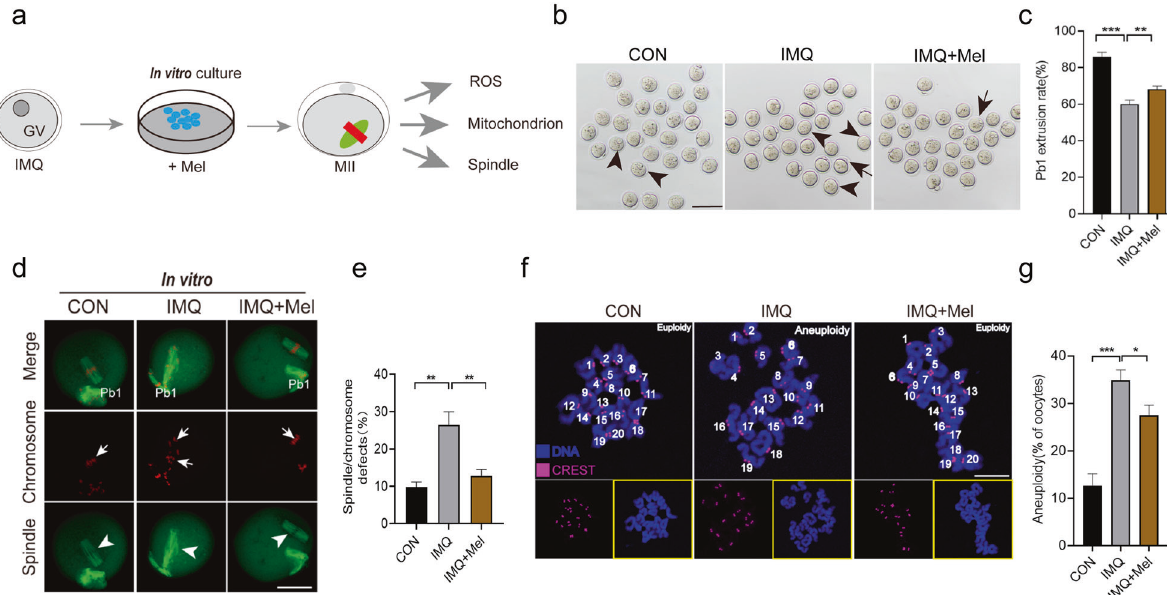
Fig. 5 Effects of melatonin supplement during in vitro maturation on the meiotic progression. a Diagram of melatonin supplement during in vitro maturation. b Phase-contrast images of in vitro-matured oocytes collected from CON, IMQ and IMQ + Mel mice. Scale bars: 200 µm. c Mensurable analysis of Pb1 extrusion rate, 150 CON, 165 IMQ, and 140 IMQ + Mel oocytes were included in the experiment. d Confocal images of spindle morphology and chromosome alignment in the CON, IMQ, and IMQ + Mel oocytes that matured in vitro. Arrows point to disorganized spindles; arrowheads point to misaligned chromosomes. Scale bar: 40 µm. e Quanti fi cation of MII oocytes that matured in vitro with spindle defects and chromosome disalignment. 102 CON, 115 IMQ, and 120 IMQ + Mel oocytes were tested. f Karyotype analysis diagram of MII oocytes from the CON, IMQ, and IMQ + Mel group. Scale bar: 20 µm. g The proportion of aneuploidy in CON ( n = 20), IMQ ( n = 25), and IMQ + Mel ( n = 21) oocytes. The data are shown as mean ± SD. * P < 0.05, ** P < 0.01, *** P < 0.001.